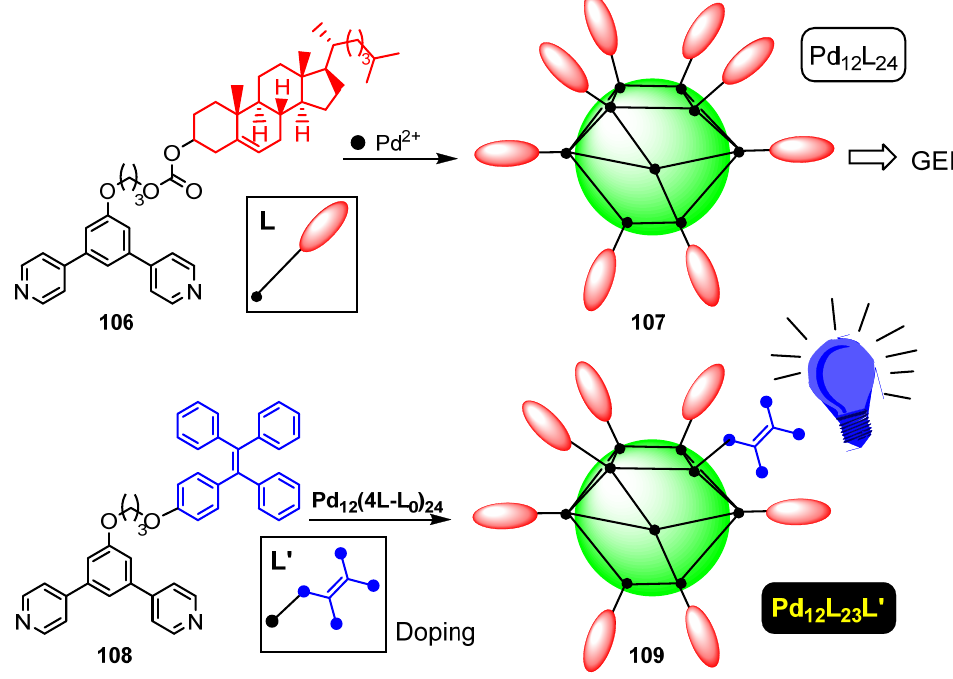
Figure 30. Schematic representation of complexes Pd 12 L 24 (not all groups shown) with the bis(pyridin)-cholesteryl derived ligands ( up ) and the doped complexes showing fluorescence ( down ). Adapted from [105].